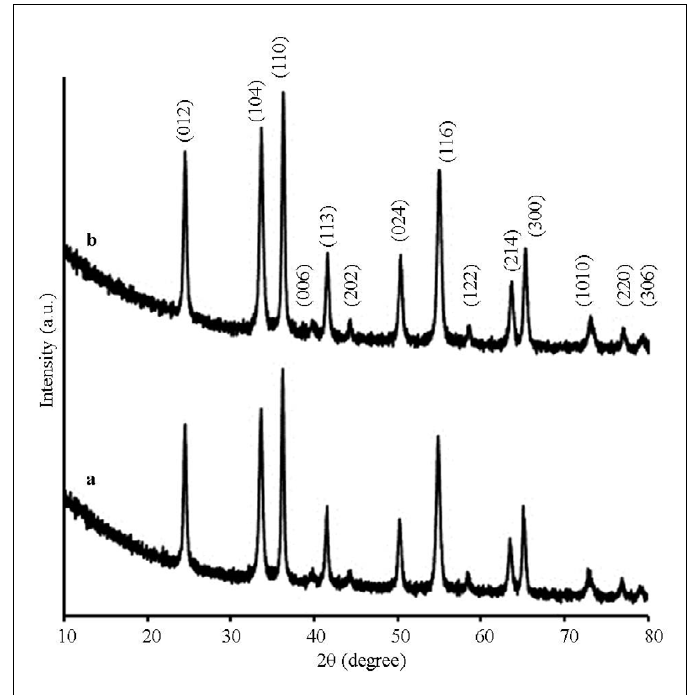
Fig. 4. XRD patterns of the as-prepared Cr 2 O 3 nanoparticles at a) 500 ºC and b) 600 ºC